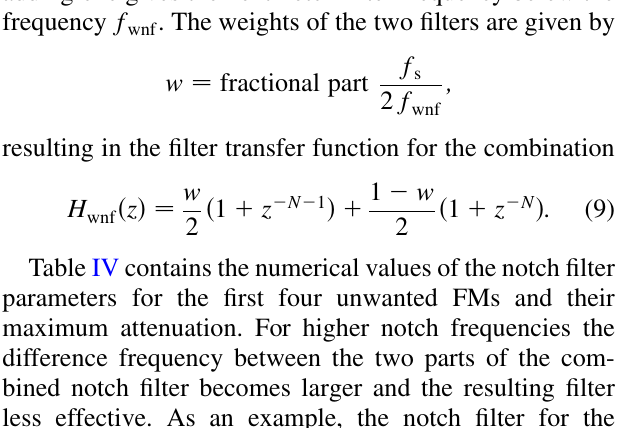
(cid:3) 1 (cid:1) s . For comparison, the loop (cid:2) -mode, the 7 (cid:2) -mode, and the 9 9